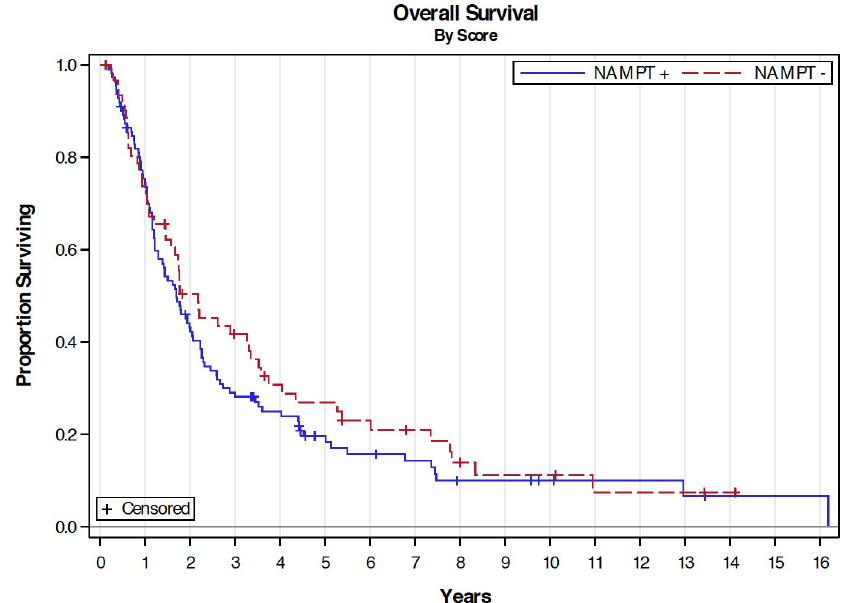
Fig 2. Overall survival by NAMPT IHC score. Kaplan-Meier curves showing overall survival of patients with NAMPT+ (blue line) and NAMPT- (red line) PDA. Median OS: 20.4 months (NAMPT+) vs. 26.0 months (NAMPT-); P -value: 0.34.